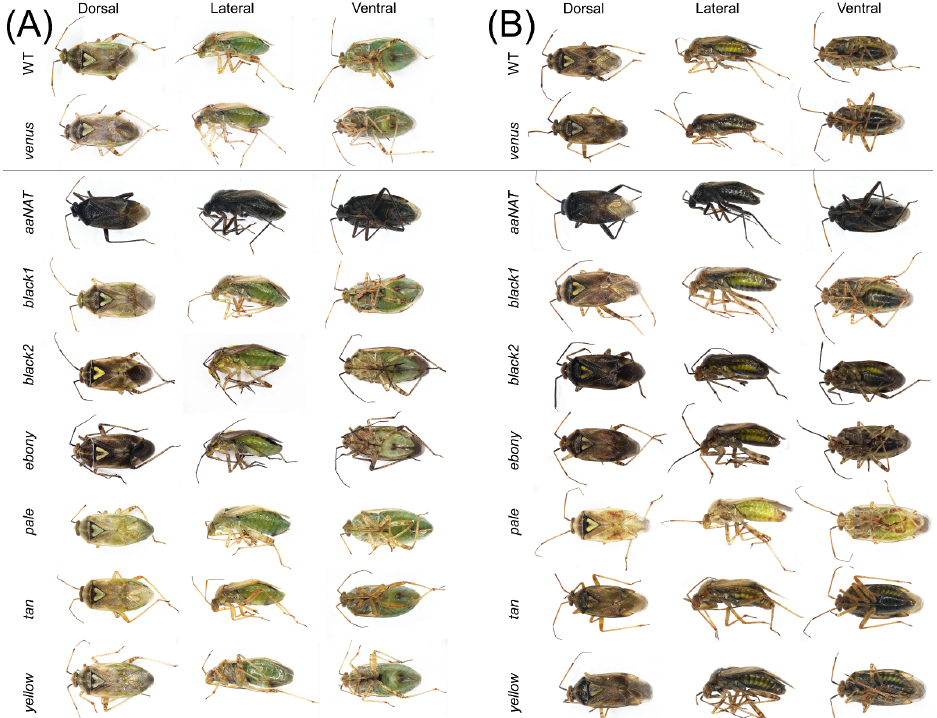
Figure 6. Effects of RNA interference-mediated knockdown on Lygus hesperus cuticle coloration. Shown are full-body images (dorsal, lateral and ventral views) of ( A ) female and ( B ) male L. hesperus adults at 7 days post-eclosion that were either untreated wildtype (WT) or injected as 5th instars with dsRNA of the control gene venus, or the indicated cuticle pigment-associated gene. Images are representative of three biological replicates consisting of 40 bugs of each sex.